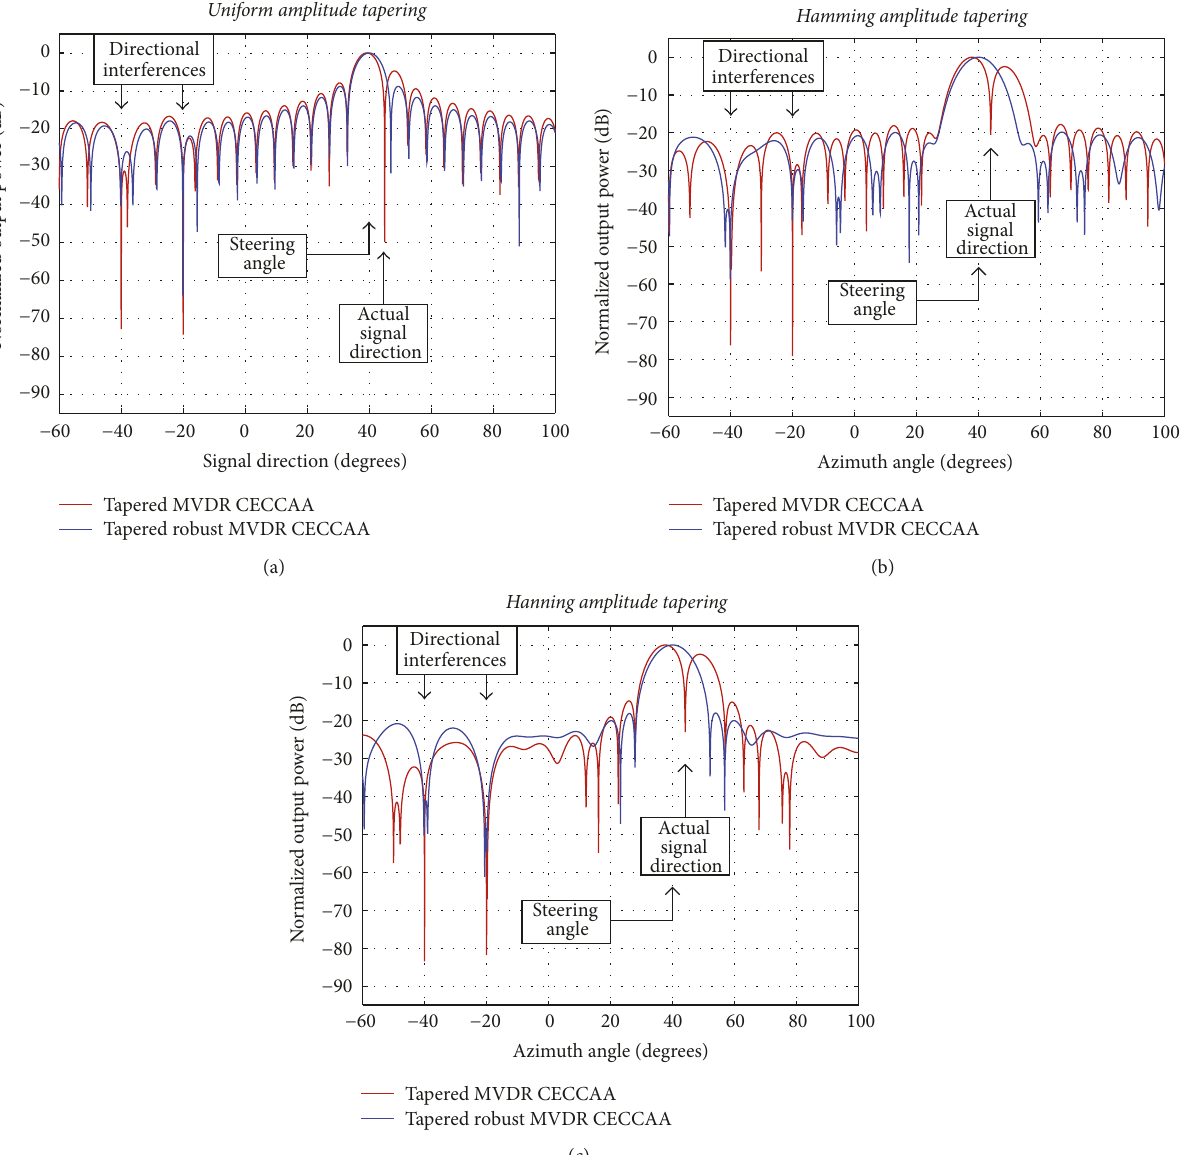
Figure 8: (a) Normalized power pattern comparison of the MVDR beamformer and robust MVDR beamformer by using uniform tapering in the presence of array imperfections. (b) Normalized power pattern comparison of the tapered MVDR beamformer and proposed tapered robust MVDR beamformer by using Hamming amplitude tapering in the presence of array imperfections. (c) Normalized power pattern comparison of the tapered MVDR beamformer and proposed tapered robust MVDR beamformer by using Hanning amplitude tapering in the presence of array